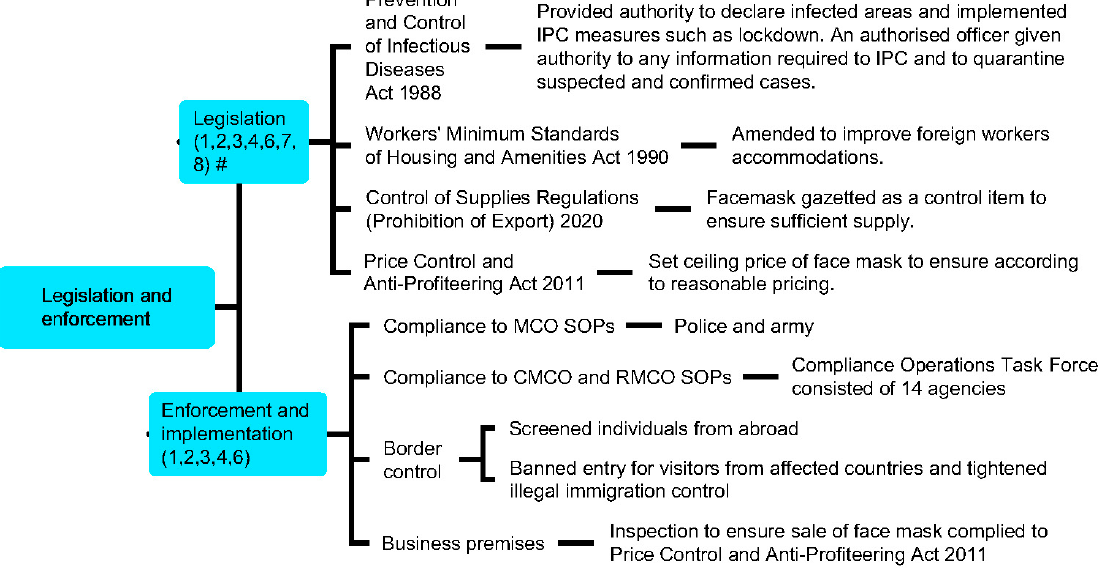
Figure 6. Relevant laws and regulations enforced by the Malaysia in response to the COVID-19 pandemic. # Numbers in parentheses denote WHO Pillars.